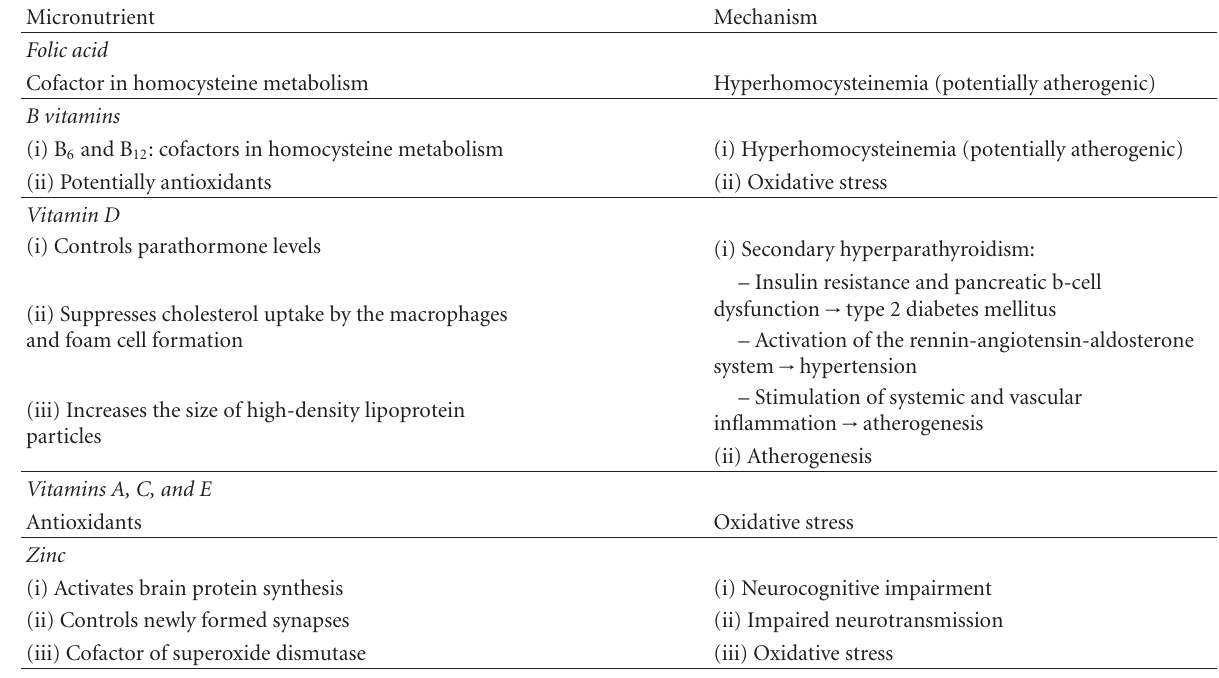
Table 1: Micronutrients and mechanisms through which their deficiencies induce cerebrovascular alterations and increase the risk of